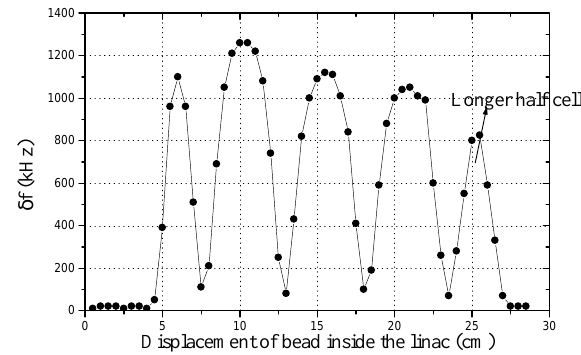
FIG. 8. Frequency deviation from the resonant frequency in the bead-pull test of the PWT3 linac